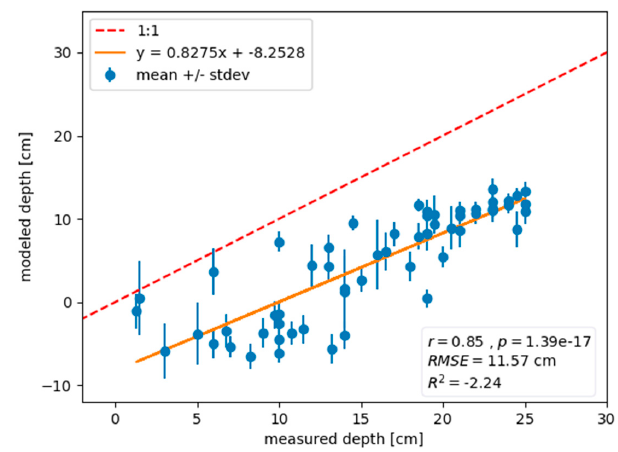
Figure 6. Scatter plot of measured vs. modeled pond depth ( n = 60).